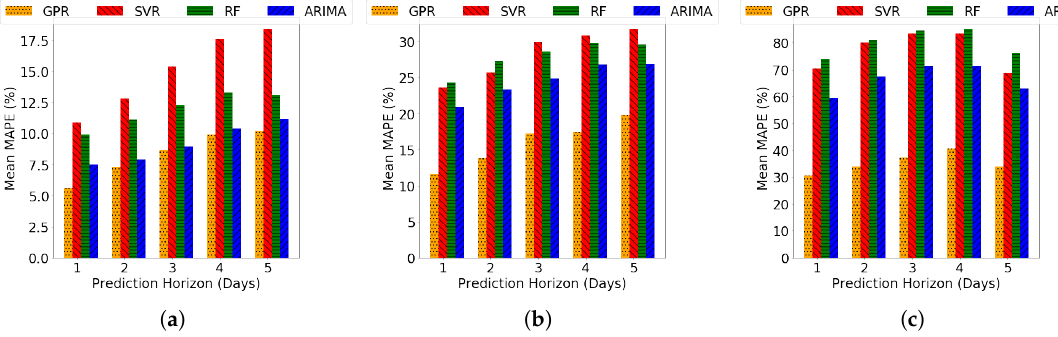
Figure 7. Mean of the MAPE of prediction over duration of training data for varying duration of prediction horizon using GPR, SVR, RF and ARIMA. ( a ) CMU electricity load; ( b ) Y2E2 cooling load; ( c ) Y2E2 lighting load.